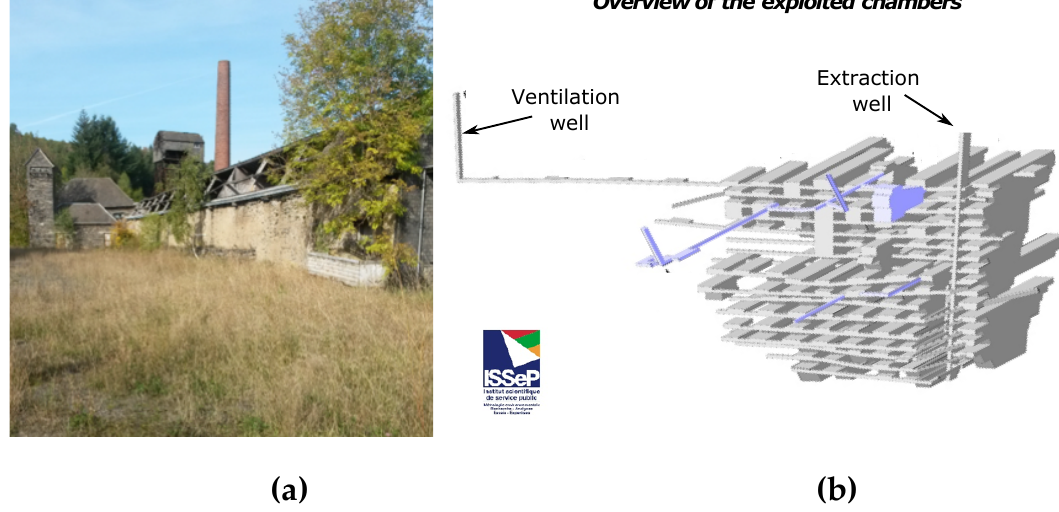
Figure 2. ( a ) The slate mine on the Martelange site; ( b ) 3D model of the mine made by Institut scientifique Wallon de surveillance, de sûreté et de recherche en environnement